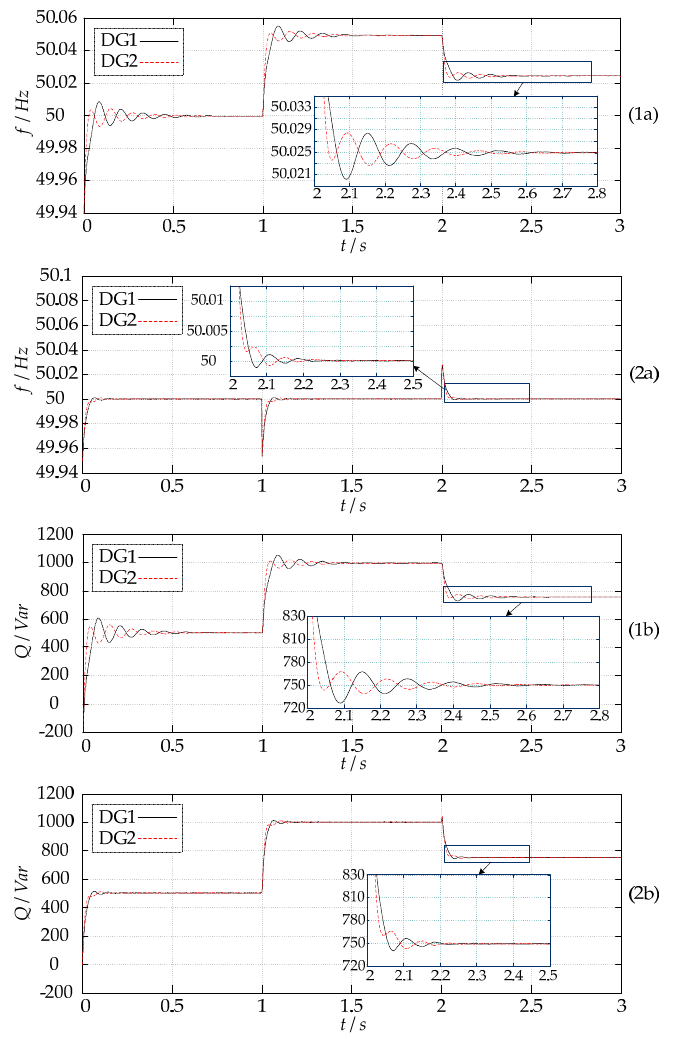
Figure 9. Simulation results of reactive power/frequency: method 1 (traditional method) using constant frequency reference; method 2 (proposed method) using CFR. ( 1a ) DG running frequency in method